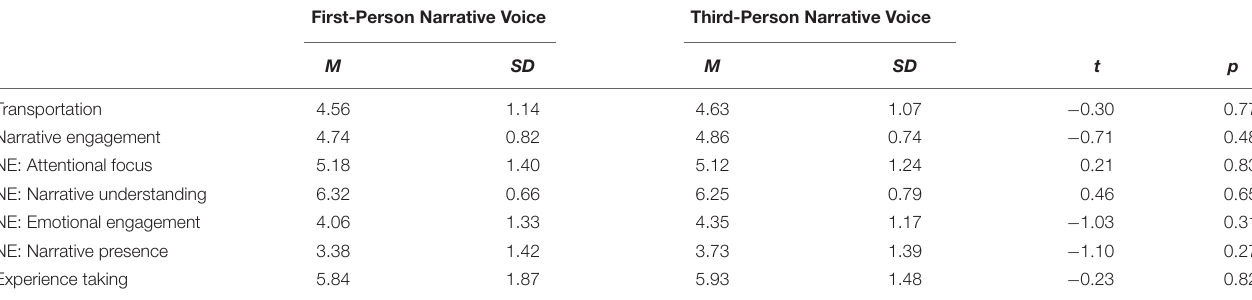
TABLE 2 | Results of t -tests for independent samples between narrative voice and descriptive statistics (Study 2). First-Person Narrative Voice Third-Person Narrative Voice